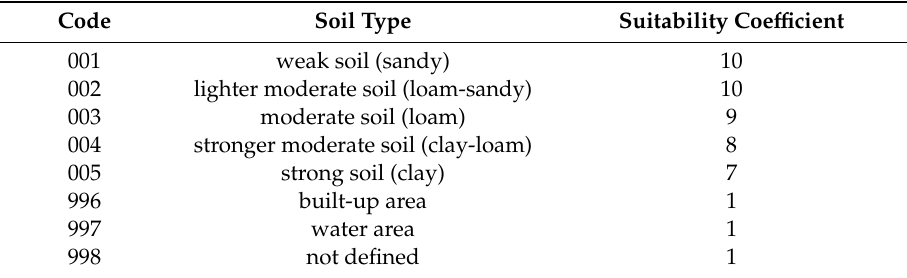
Table 5. Codes of soil types and their suitability for deployment of